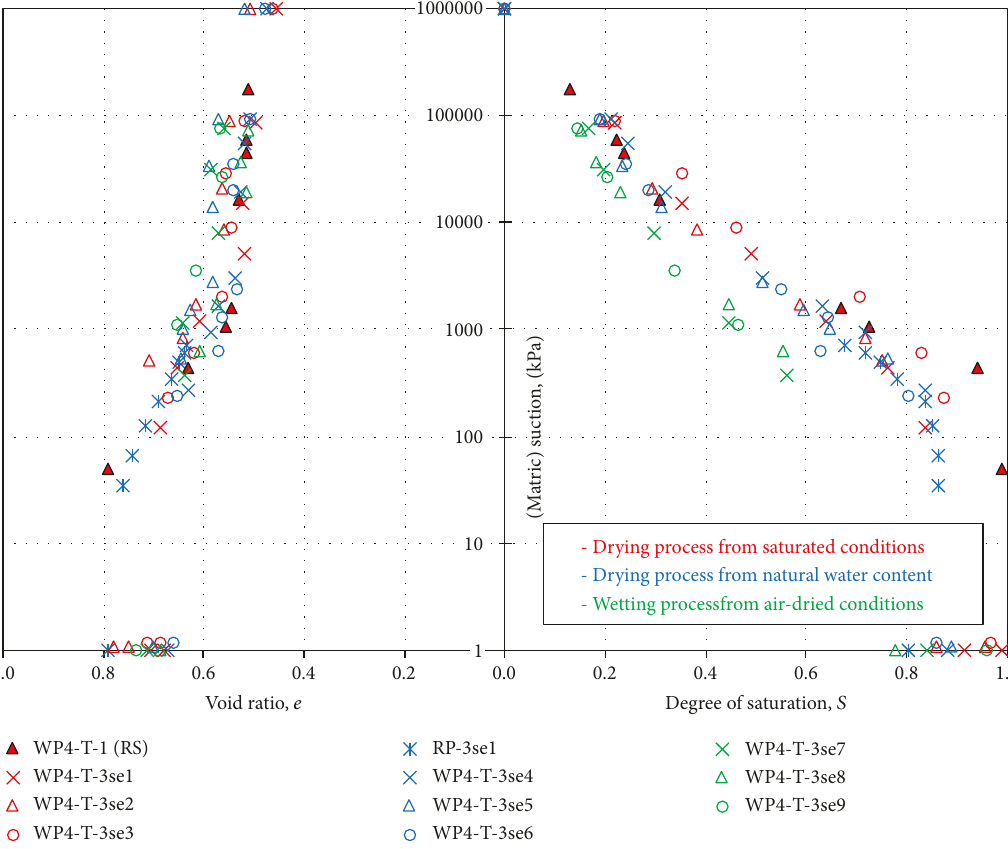
Figure 7: S - ψ - e measurements obtained using the WP4-T and pressure plate extractor apparatus.